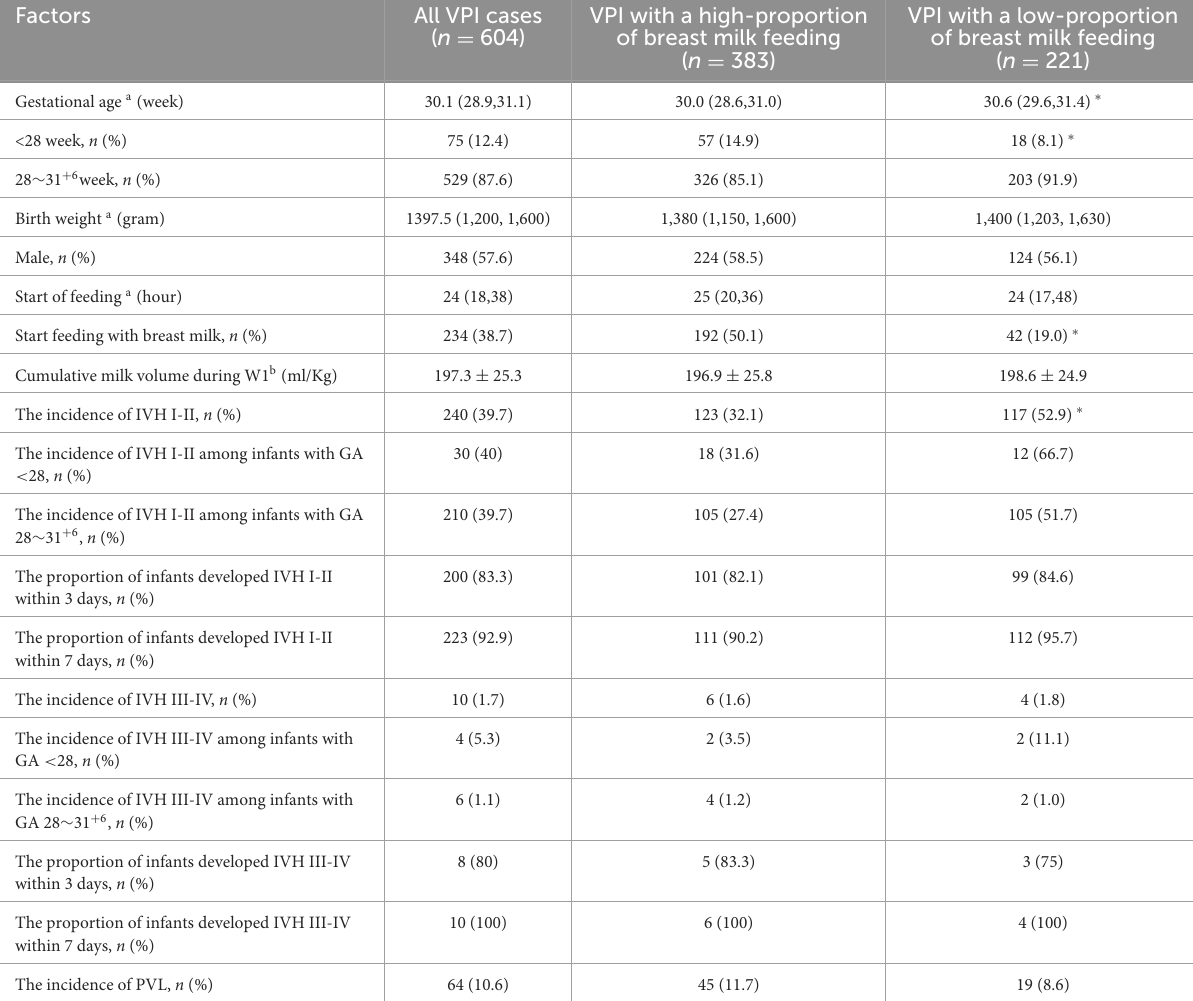
TABLE 1 Characteristics of all VPIs and high/low-proportion breast milk feeding VPIs.